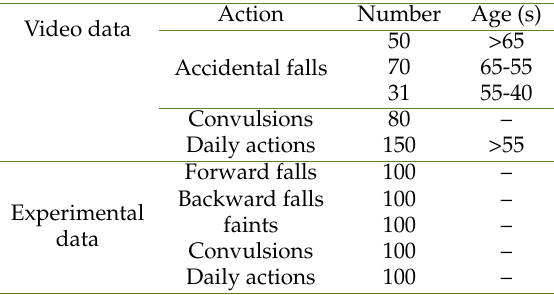
Table 2. Specific information of experimental data.